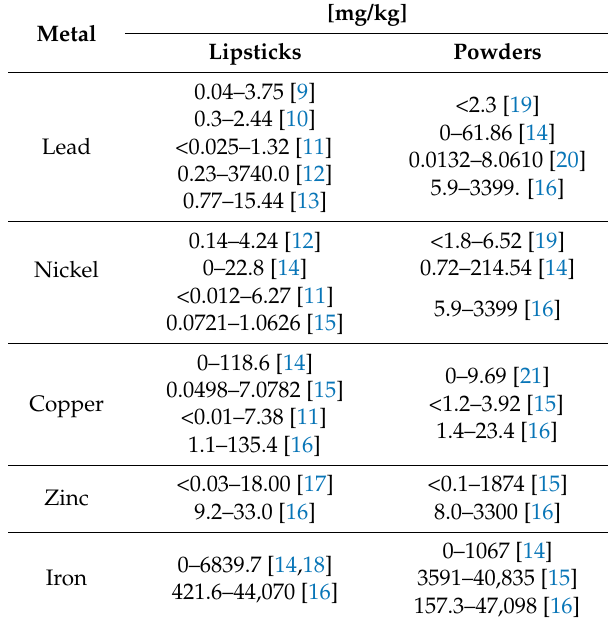
Table 3. Selected literature data of heavy metal concentrations in lipsticks and powders (references are given in square